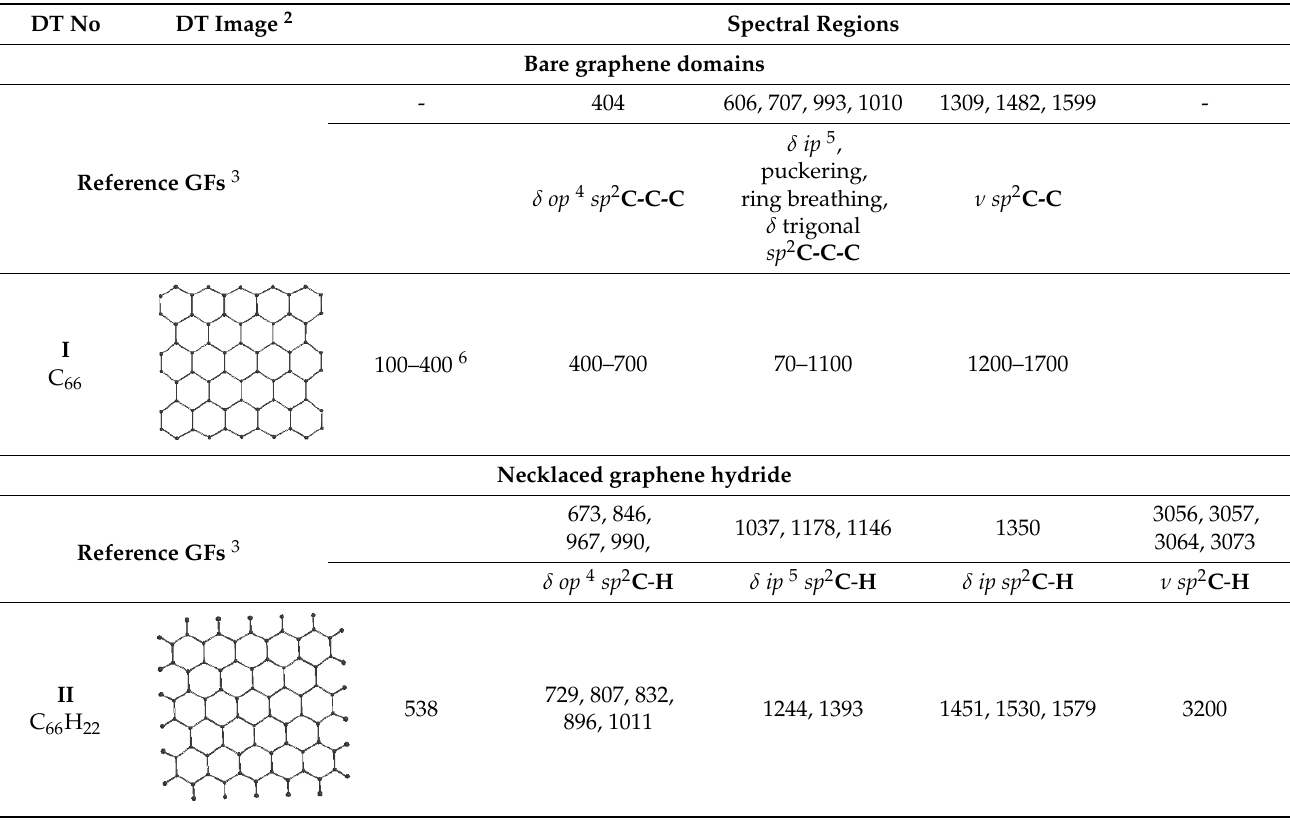
Table 1. The UHF general frequencies kits of the bare graphene domains and necklaced graphene hydrides 1 , cm −1.